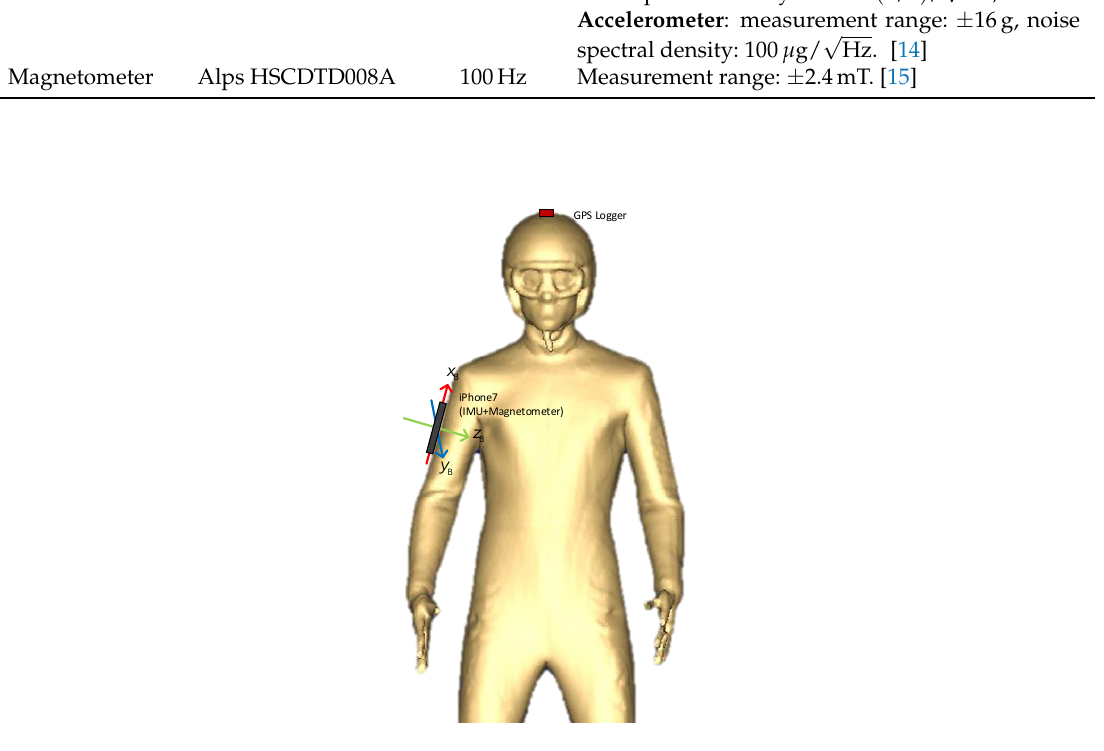
Figure 1. Illustrative figure on the placement of the sensors (based on a body scanning